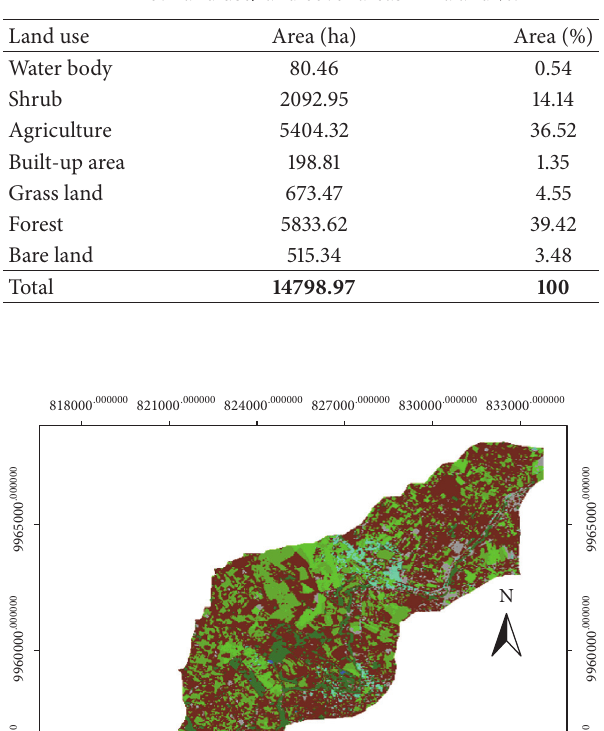
Table 3: Land use/land cover areas in ha and %.